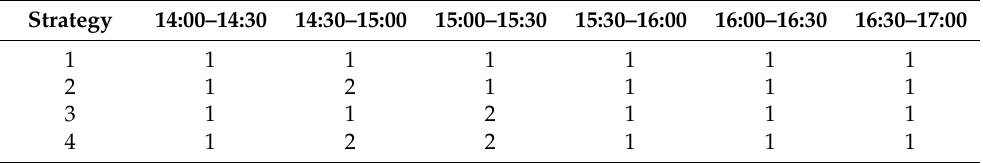
Table 1. Security lane allocation strategies, indicating how many security lanes are open per time interval.